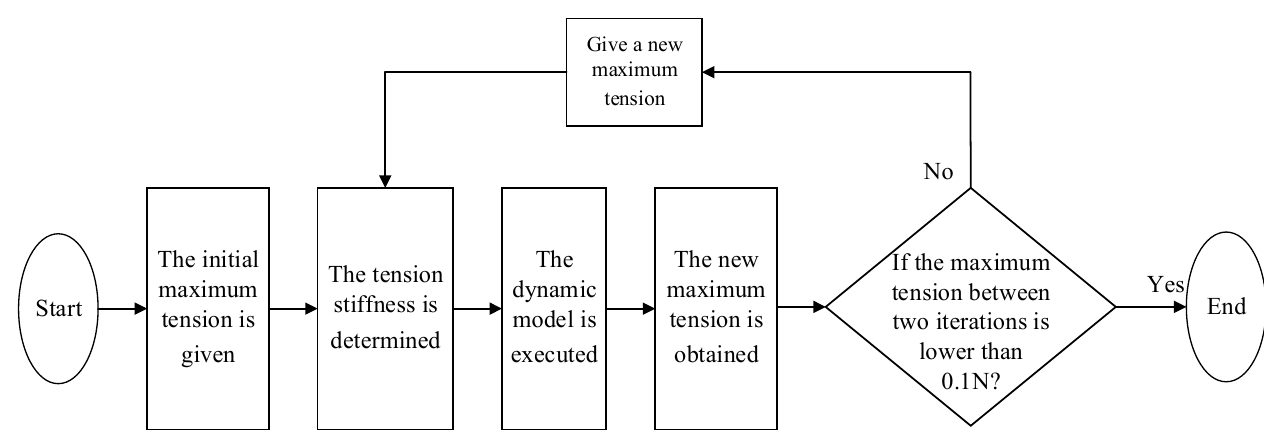
Figure 7. The flowchart to determine line stiffness.